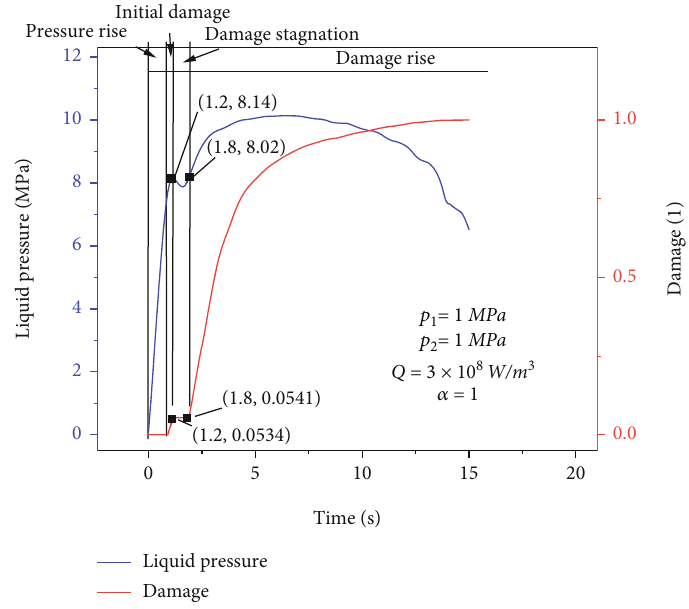
Figure 5: Pressure-damage comparison curve at point O2.